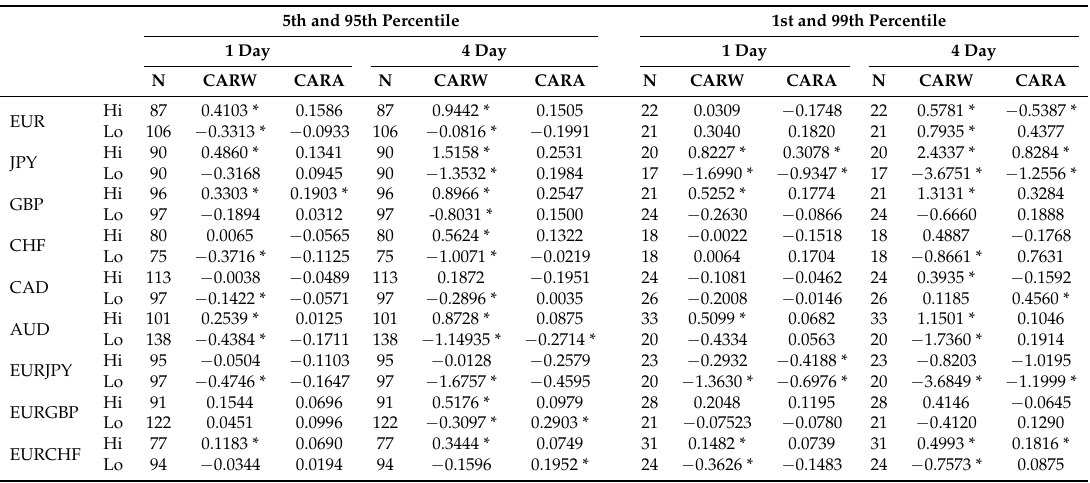
Table 1. Event Study: Cumulative Abnormal Returns and Extreme Risk Reversal. 5th and 95th